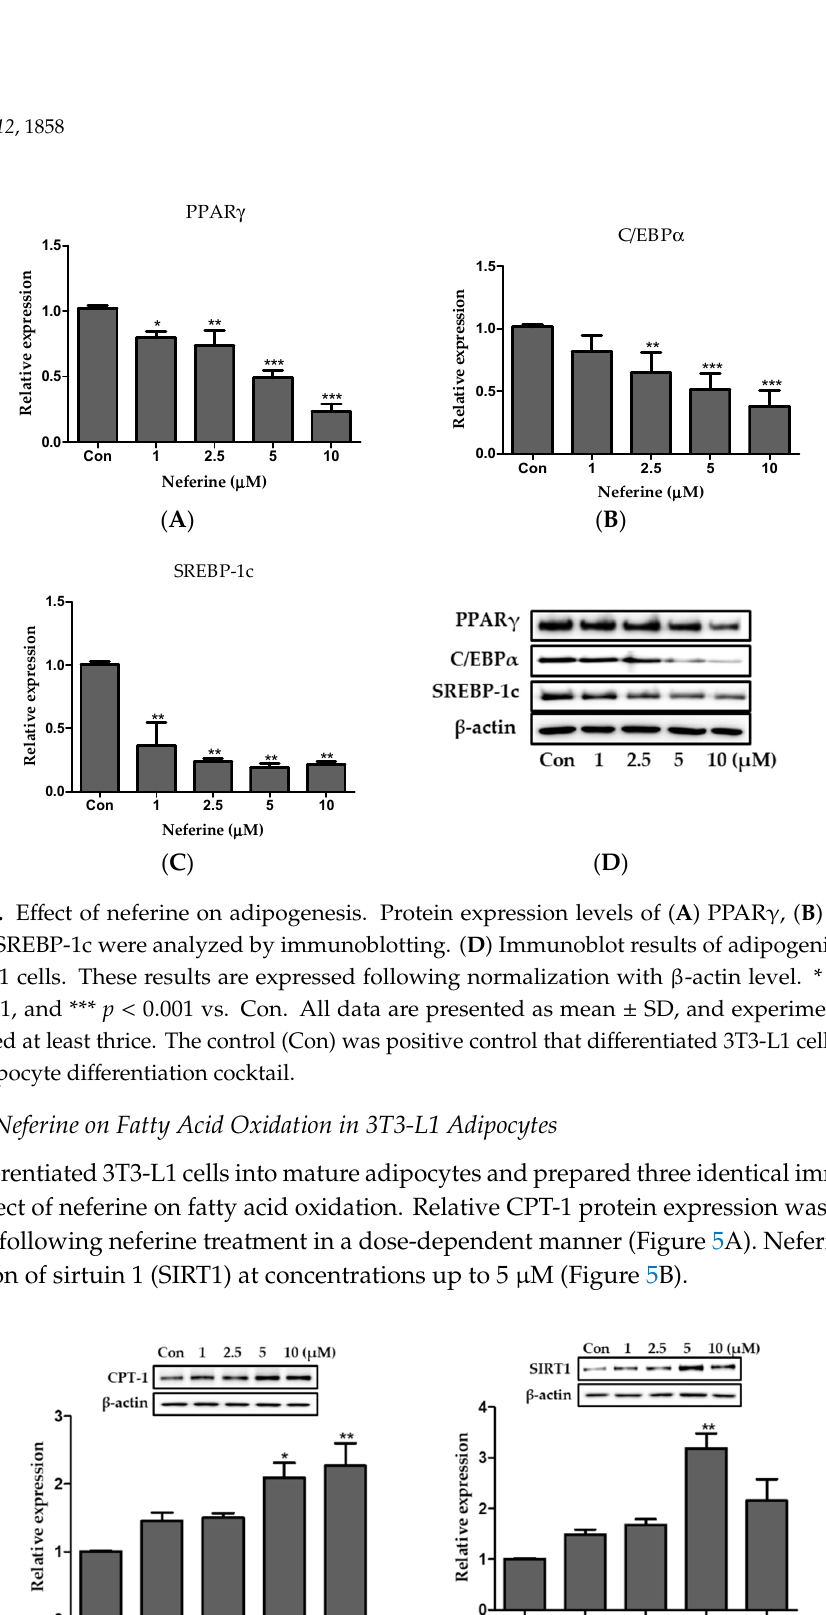
Figure 5. Effect of neferine on the expression of the protein involved in fatty acid oxidation. Western blotting was carried out to analyze the protein expression of ( A ) CPT-1 and ( B ) SIRT1 following normalization to β -actin. * p < 0.05, ** p < 0.01, and *** p < 0.001 vs. Con. All data are presented as mean